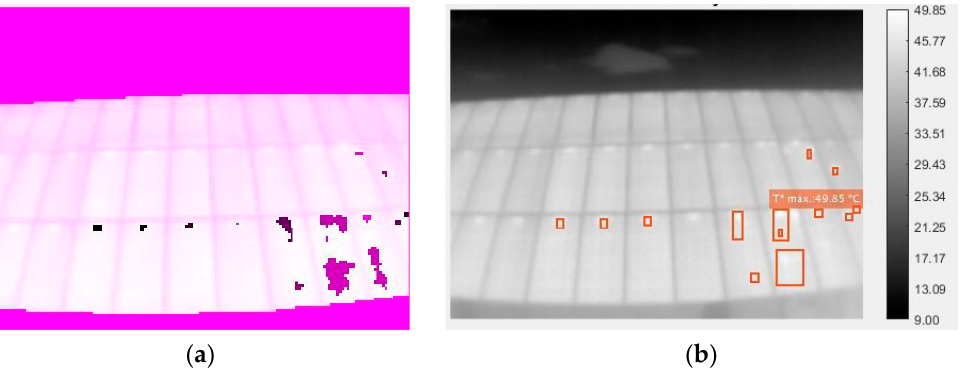
Figure 11. ( a ) segmentation of the hot-spots; ( b ) final image of the detected points, which are marked, and their calculated temperatures (only the highest temperature is shown for clarity reasons).